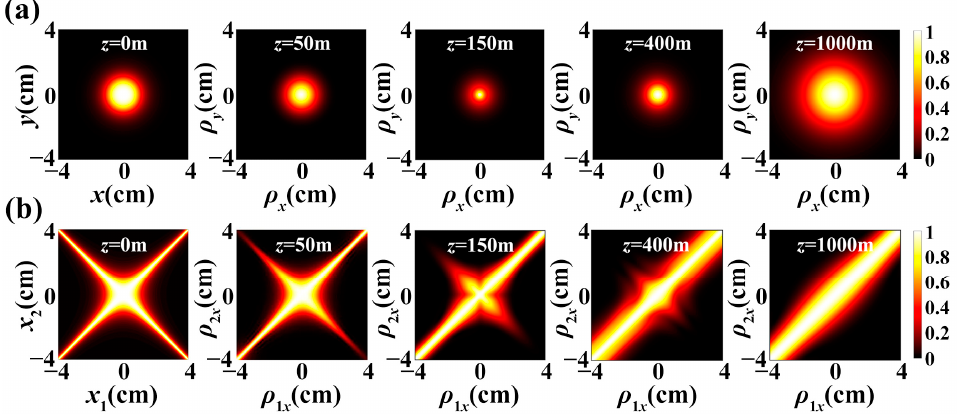
Figure 4. Evolution of the ( a ) normalized spectral intensity and ( b ) spectral DOC on propagation in oceanic turbulence.